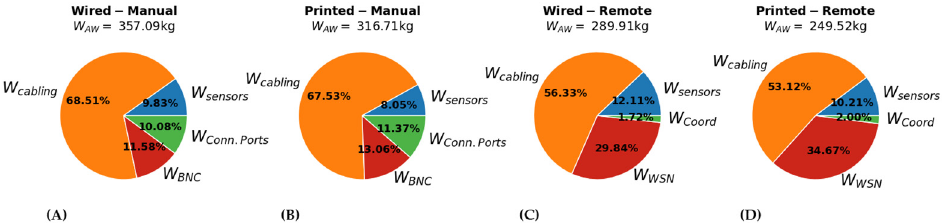
Figure 8. Breakdown of W AW for the ( A ) Wired–Manual, ( B ) Printed–Manual, ( C ) Wired–Remote, and ( D ) Printed–Remote SHM system configurations.